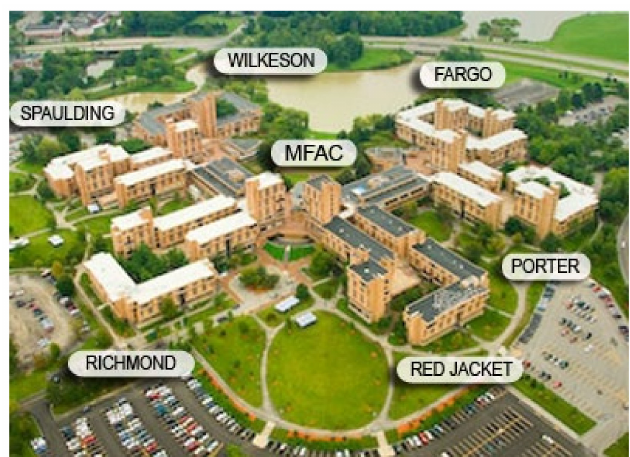
Figure A1. Arial photograph of the Ellicott complex.